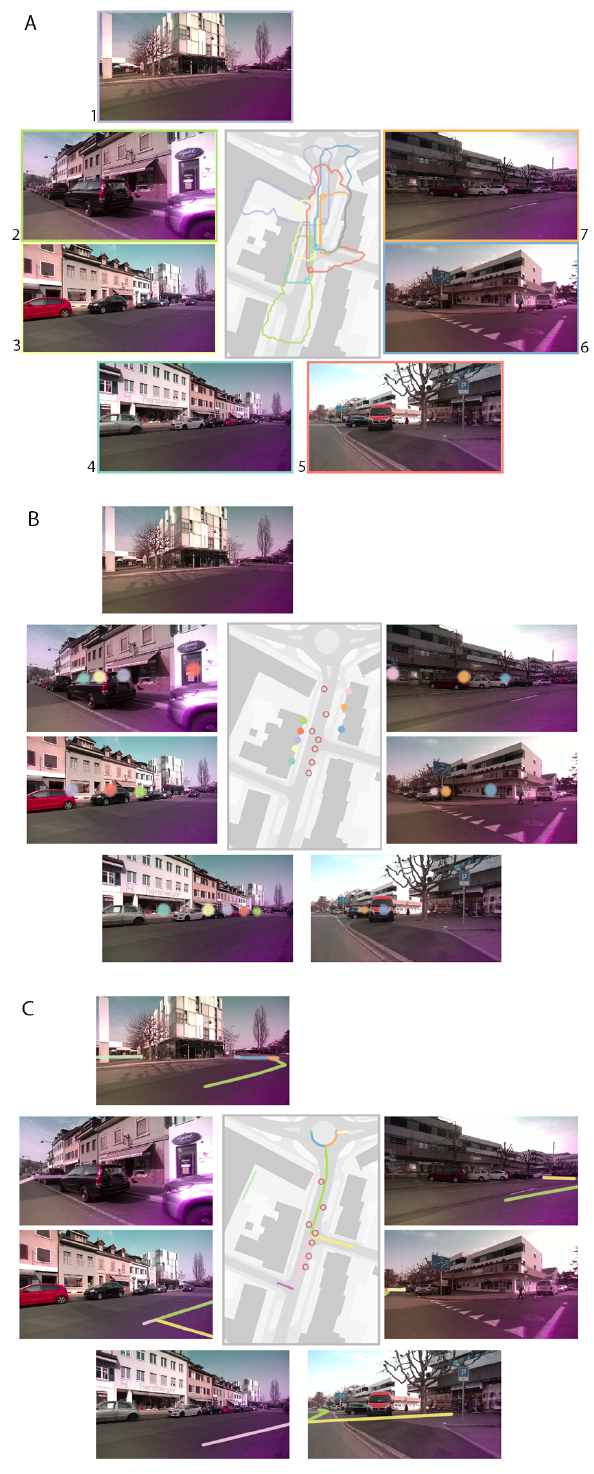
Figure 2. Identical scene with different types of colour-coded visual cues that link camera views and map. From top to bottom: simplified viewshed, dot cues, street centre line cues. (images: (Nebiker et al., 2021), geo-data: (Amt f¨ur Geoinformation Kanton Basel-Landschaft, 2021, Bundesamt f ¨ ur Landestopografie swisstopo, 2021)). Image 2 illustrates a potentially misleading case for both, viewshed and dot cues. In image 4, the near-end lateral viewshed outline intersects with the correct building on the map and might support correct object-wise alignment, while red and green dot cues misalign in the image and may be